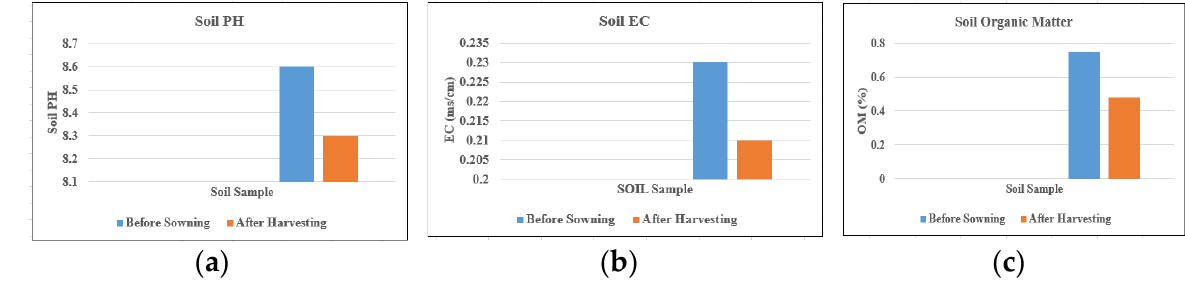
Figure 2. ( a ) Soil PH; ( b ) soil EC; ( c ) soil organic matter.